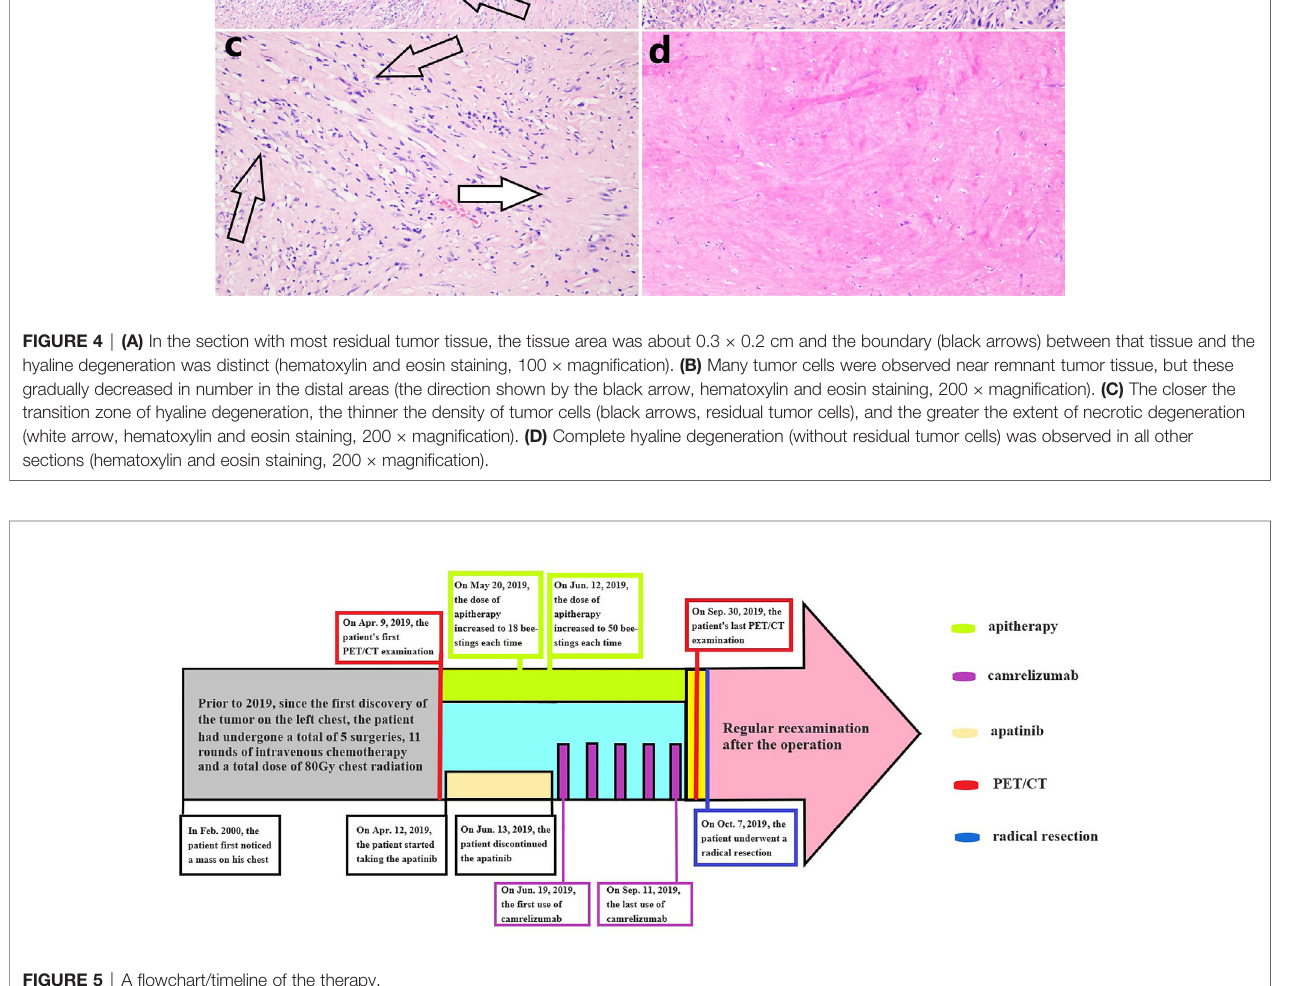
FIGURE 5 | A fl owchart/timeline of the